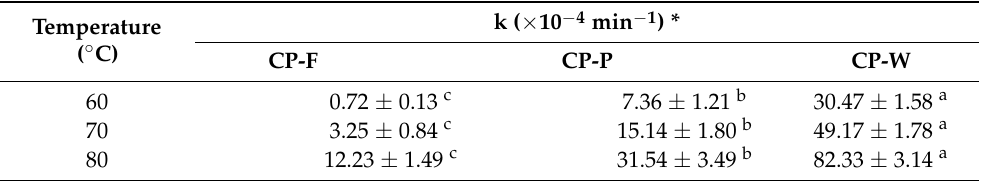
Table 2. Average thermal degradation rate constant of CP in each formulation estimated by the first order